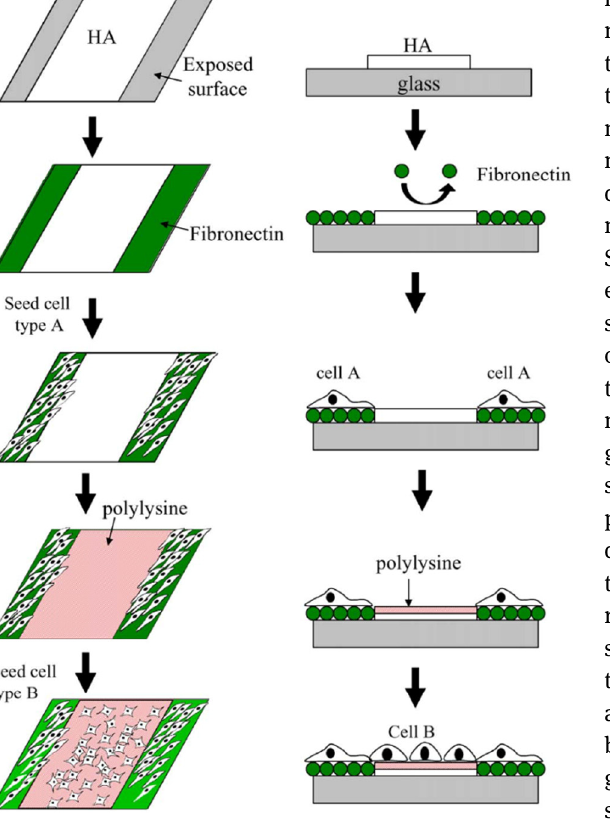
Figure 7: Schematic diagram of HA - PLL deposition on substrate. The HA surface was fi rstly deposited on substrate to prevent cell adhe - sion. Then the PLL was applied to the surface and converted HA surface to cell and protein adhesive ( reproduced from ref. [ 75 ])